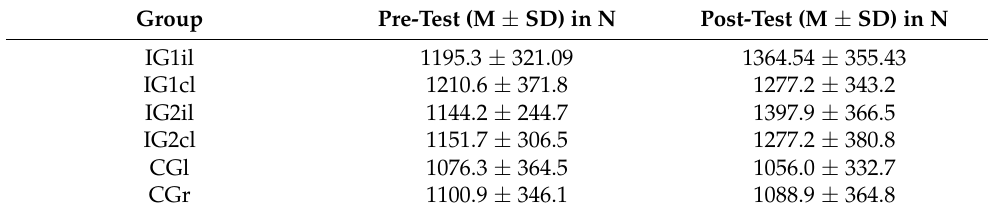
Table 2. Descriptive statistics of the maximum strength values in intervention groups as well as in control group in pre- and post-testing for the stretched